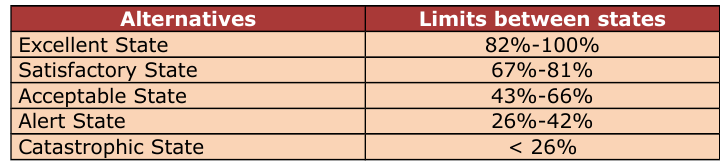
Table 8. Limit values between states considering the global